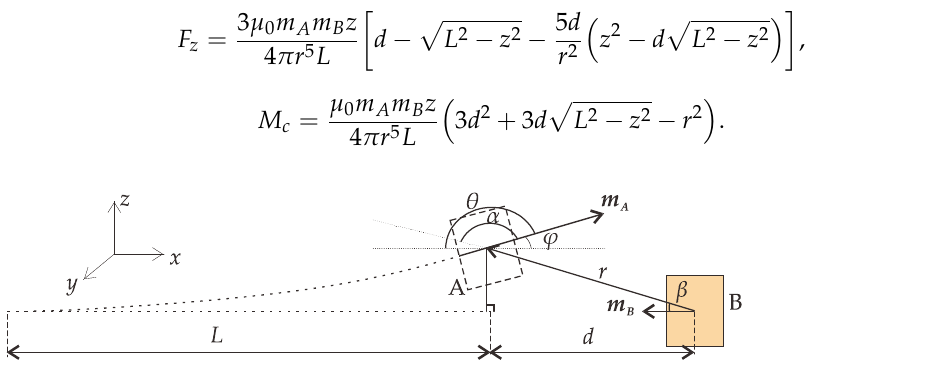
Figure 3. Geometric diagram.